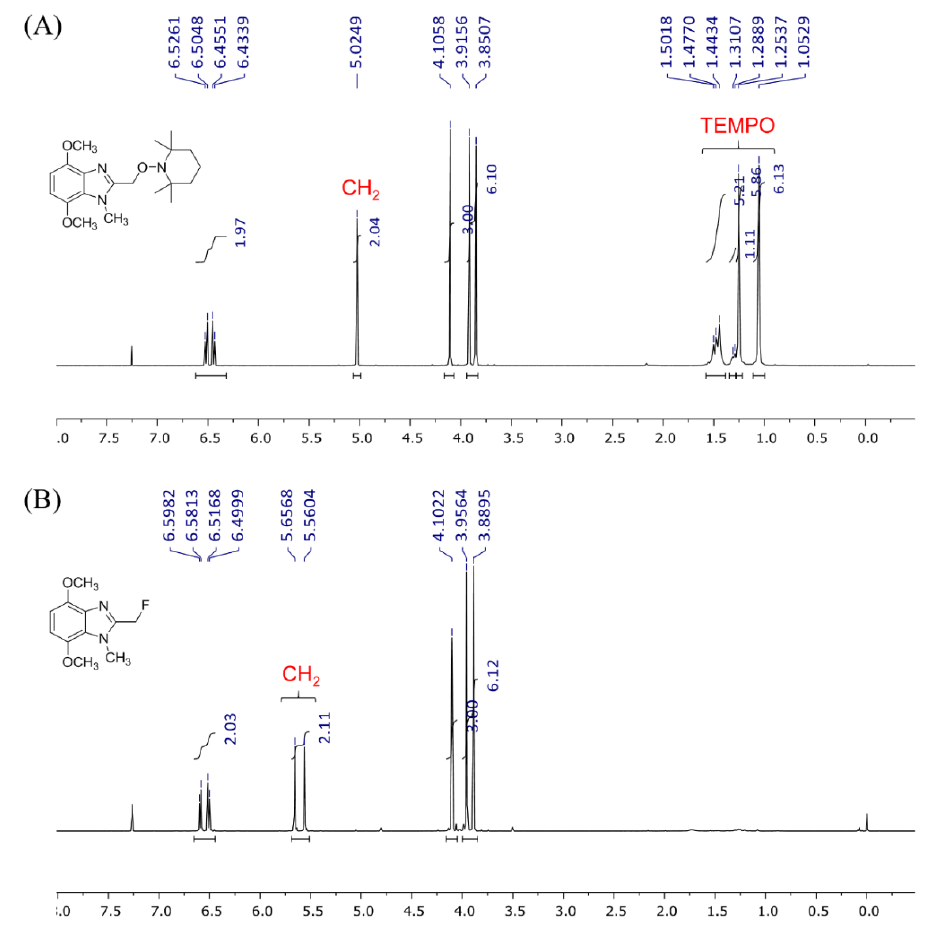
Figure 3. 1 H NMR spectra in CDCl 3 : ( A ) alkoxyamine 1 and ( B ) methylene fluoride 3 .